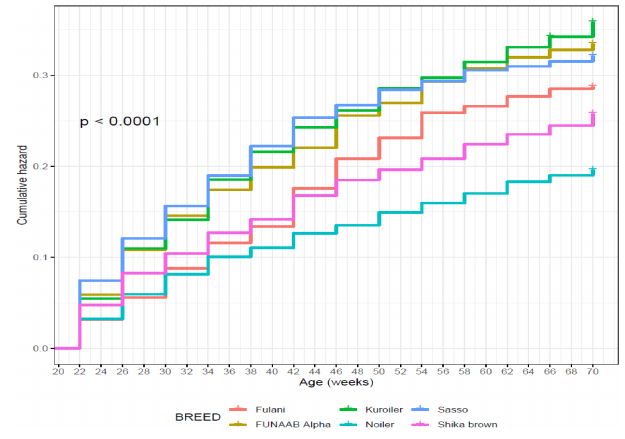
Figure 9. Effect of breed on cumulative hazard of female birds raised on-farm during laying phase in ACGG Nigeria project zones (20–72 weeks) (2016–2018).